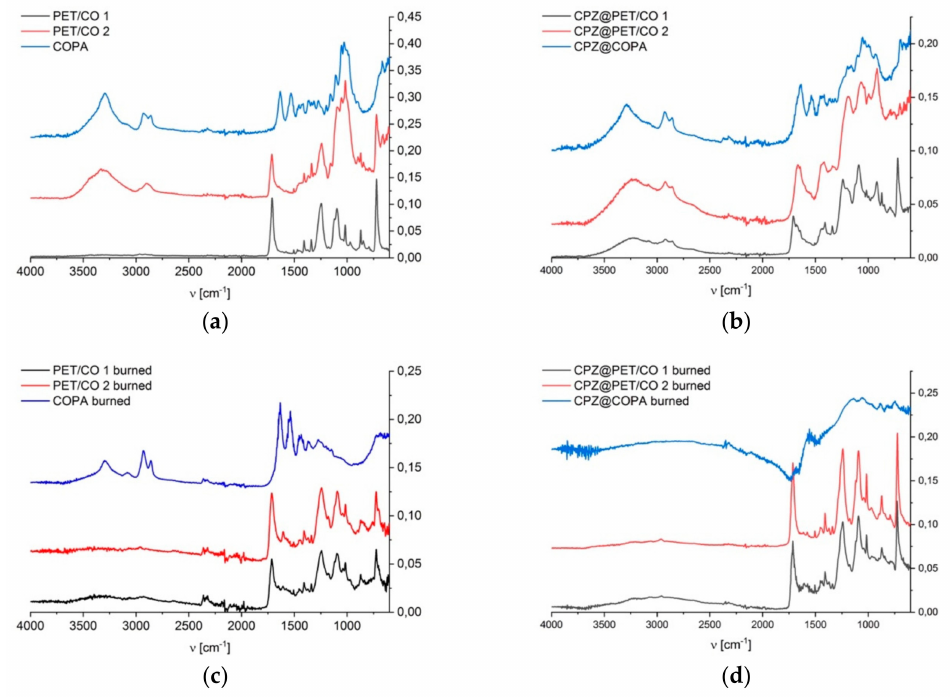
Figure 10. ATR-IR spectra of the modified blended fabrics after the flame test, according to DIN EN ISO